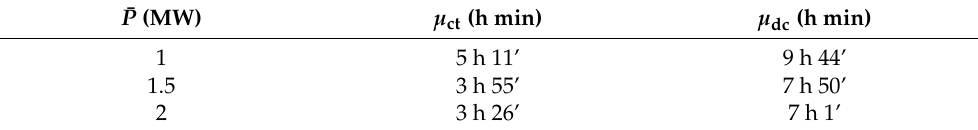
Table 2. Average of charging times and process duration for ¯ P ∈ { 1,1.5,2 } MW over 50 simulations.